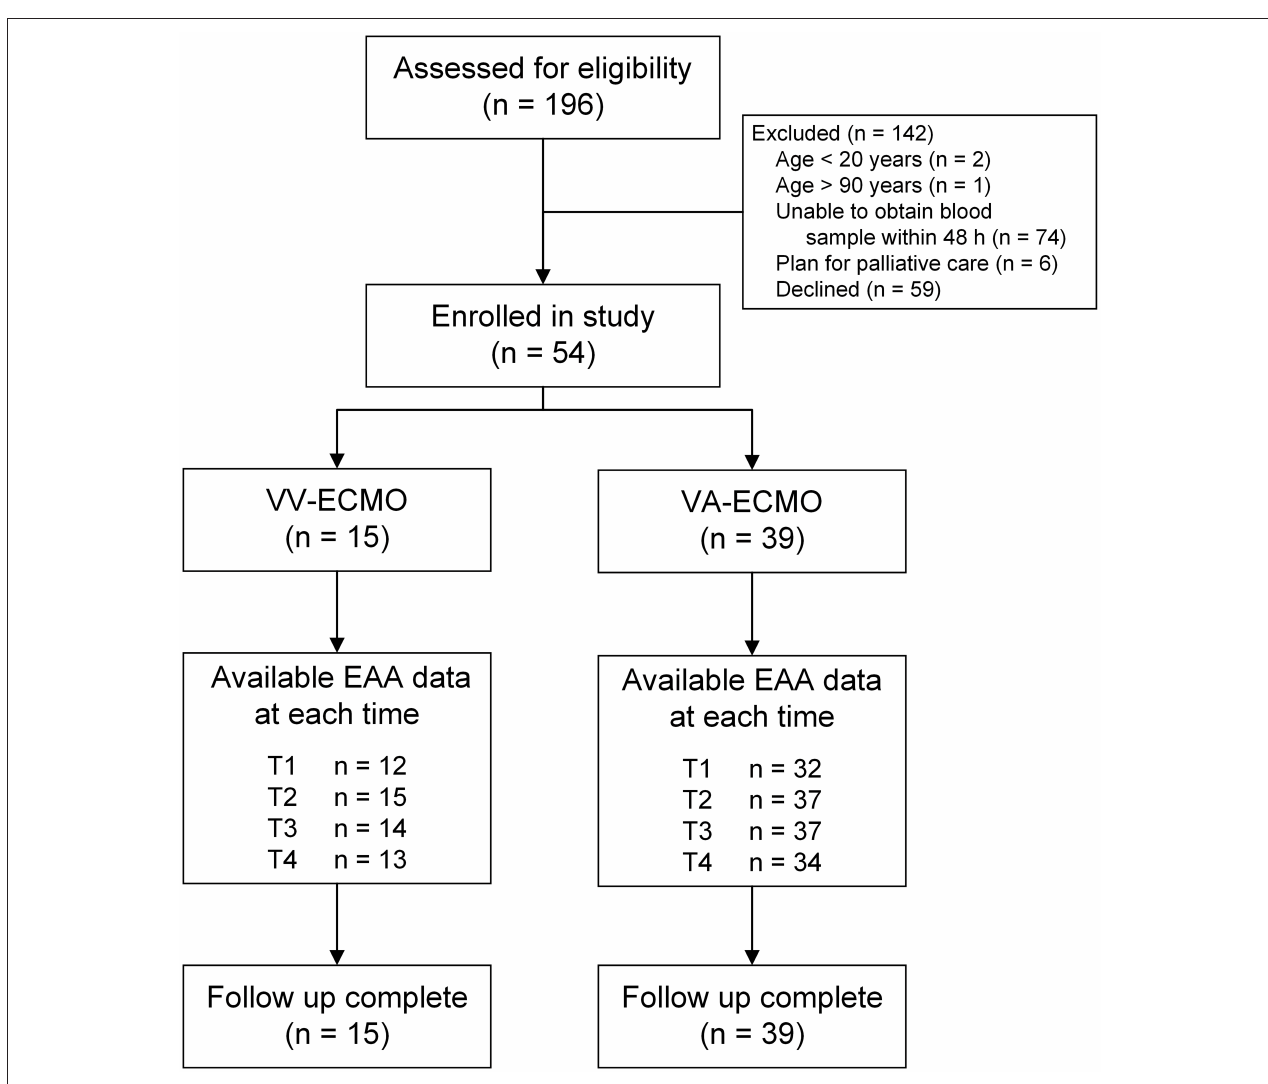
FIGURE 1 | Flow diagram. EAA, endotoxin activity assay; VA-ECMO, venoarterial extracorporeal membrane oxygenation; VV-ECMO, venovenous extracorporeal membrane